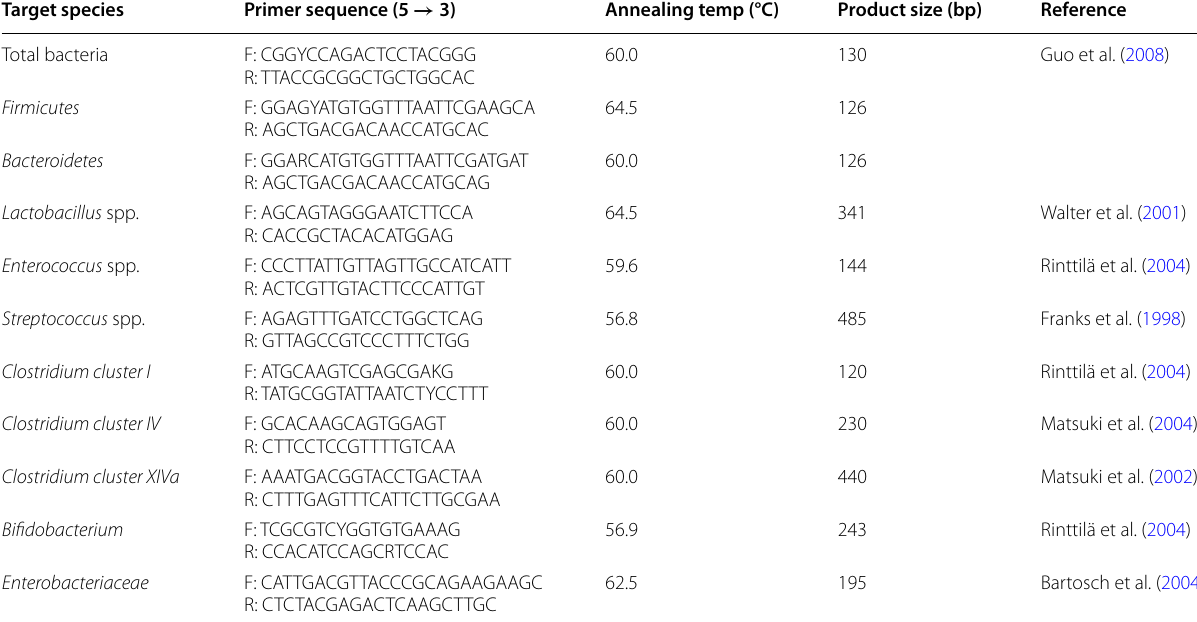
Table 3 Primers used for the quantification of the specific bacterial divisions’ expression by real-time PCR Target species